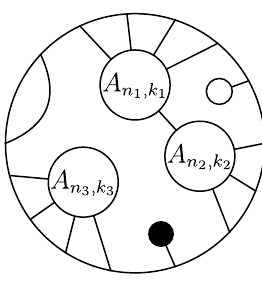
Figure 5 . Plabic diagram for a generic boundary of the momentum